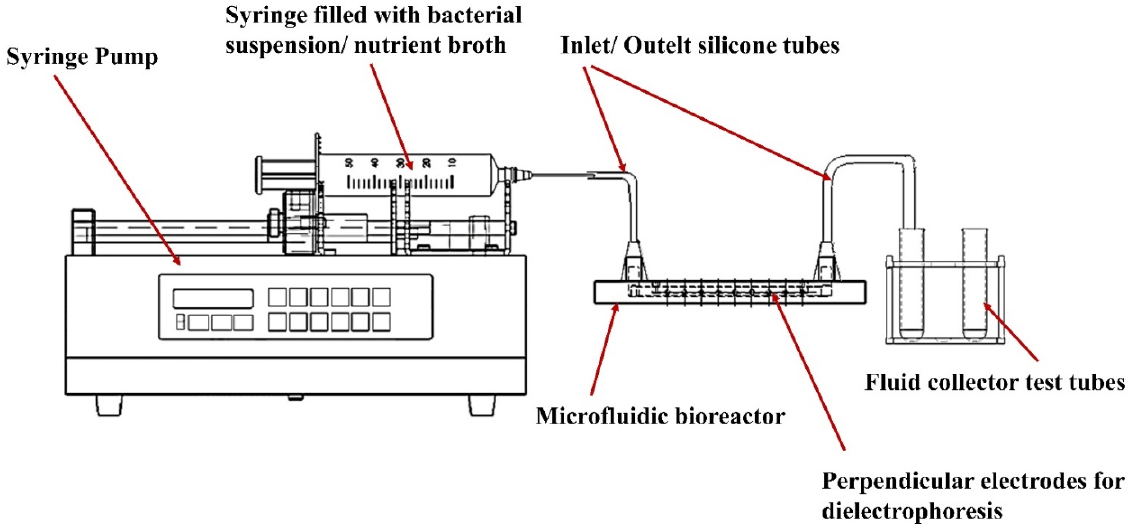
Figure 3. Schematic representation of the device setup, including a syringe pump, the syringes filled with bacterial suspension and nutrient broth, the microfluidic bioreactor, inlet/outlet silicone tubes, perpendicular electrodes, and the test tubes for final fluid collection.